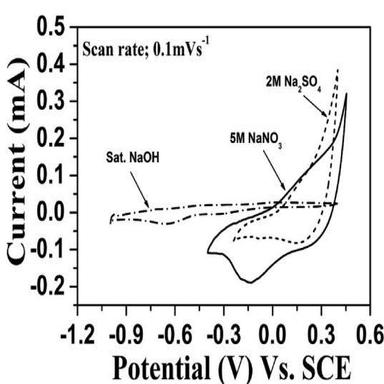
CV profiles of Na3MnCO3PO4 in different sodium electrolytes.